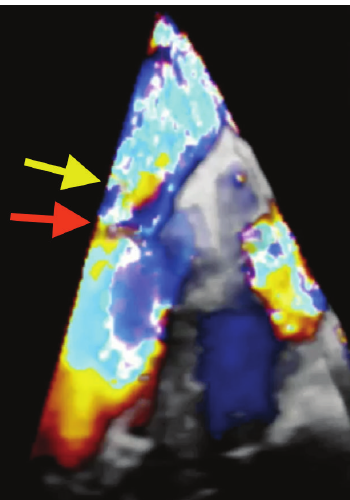
Figure 2: Color 3D TEE image on an Apical 4 Chamber view shows the impressive lateral jet (red arrow) originating from the perforation on the P2 scallop of posterior mitral leaflet. The less impressive central jet of mitral regurgitation is partially seen in this image (yellow arrow).